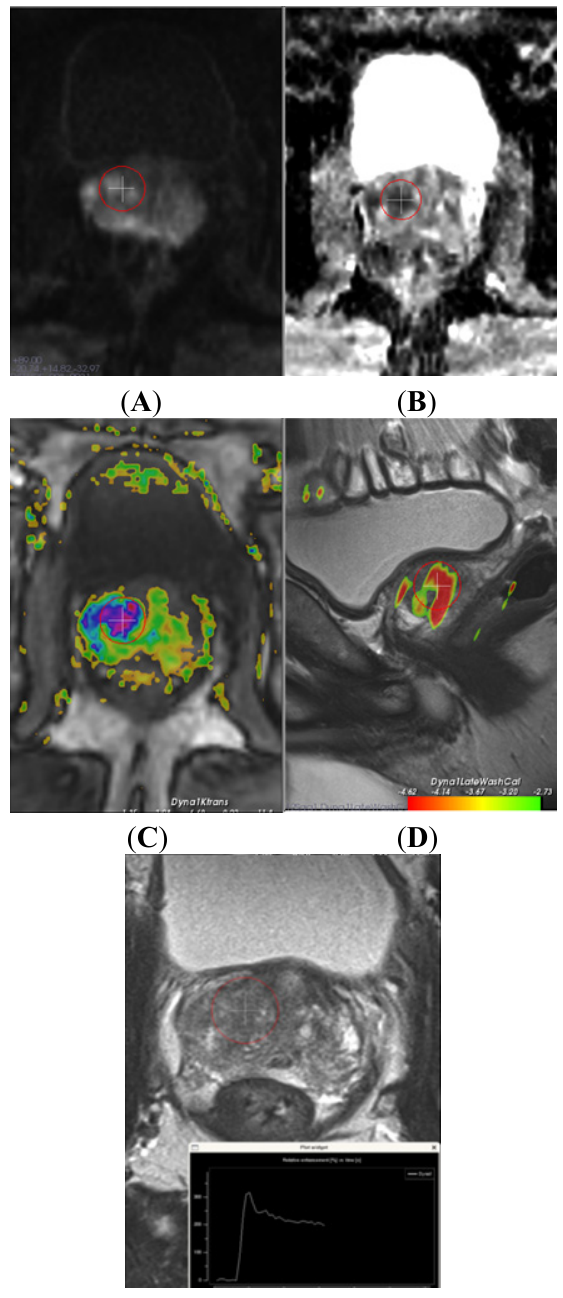
Figure 2. Multiparametric magnetic resonance (MR) imaging of the prostate of a 77 year old male, PSA level of 53, prostate cancer gene 3 (PCA3) score of 43 and 2× negative transrectal ultrasound-guided biopsy sessions. ( A ) axial diffusion weight imaging (DWI-b 1400) shows a high signal; this combined with a low signal on the ( B ) axial apparent diffusion coefficient (ADC) map, indicating restriction and, thus, suspicion for intermediate grade cancer. ( C ) axial and ( D ) sagittal dynamic contrast-enhanced MR images show increased vascular permeability. The curve (bottom) has a steep rise and wash out, which indicates cancer; ( E ) axial T2 weighted MR image shows a homogeneous low signal, which also fits tumor. MR-guided biopsy revealed in all three cores 75% Gleason 4+3 prostate